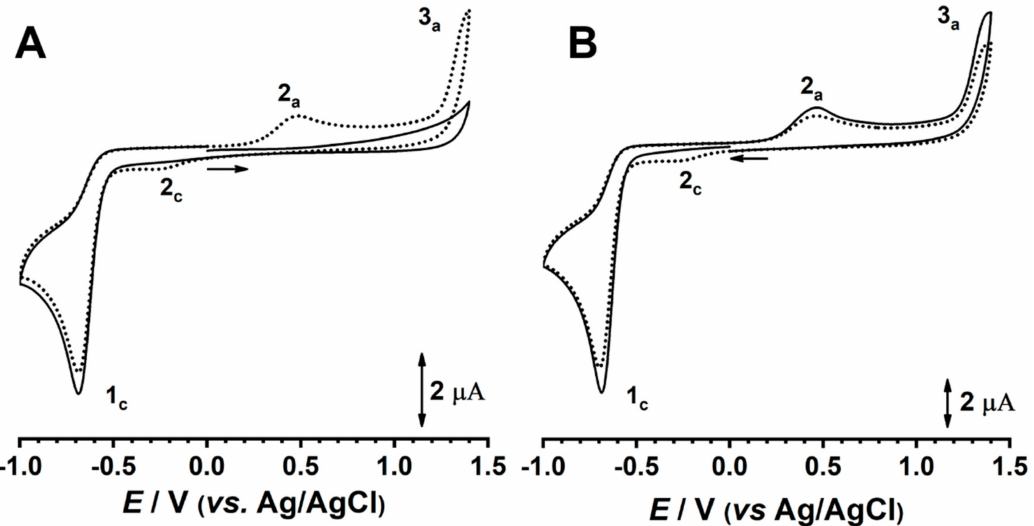
Figure 1. Cyclic voltammograms, showing ( — ) first and ( ••• ) second scans, in 500 µ M AZA in acetate buffer (0.1 M, pH 4.5): ( A ) positive-going and ( B ) negative-going scans at ν = 50 mVs − 1